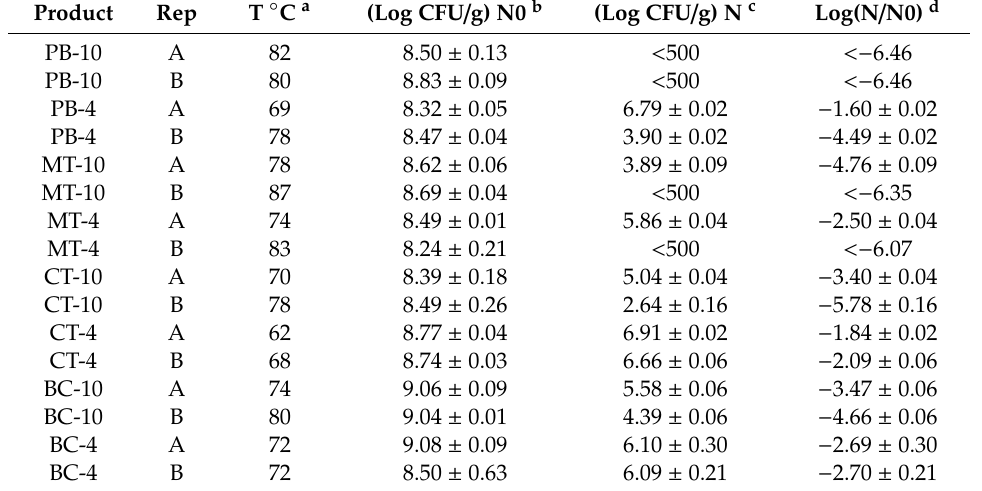
Table 3. Survival of L. monocytogenes after microwave (MW) heating treatment. Data represent the mean ± standard deviation of two technical replicates. With respect to the product column, 10 and 4 represent the storage temperatures ( ◦